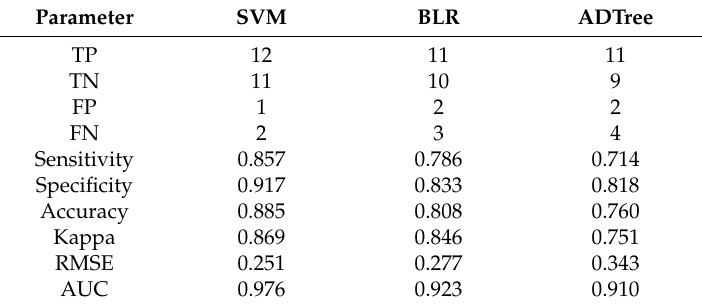
Table 5. Performances of the SVM, ADTree, and BLR algorithms on the validation